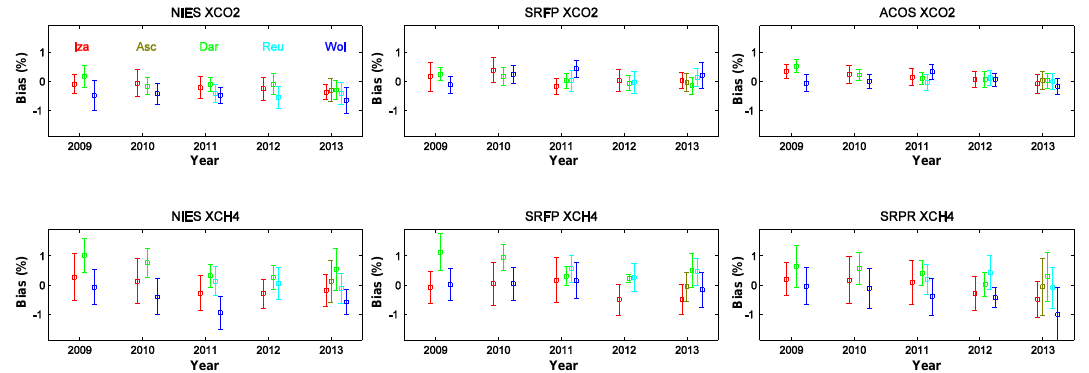
Figure 8. Annual mean bias of ocean data for each TCCON stations from different algorithms from 2009 to 2013. The error bar represents the standard deviation. Each colour represents one TCCON site (red: Izaña; olive green: Ascension Island; green: Darwin; light blue: Reunion Island; navy blue: